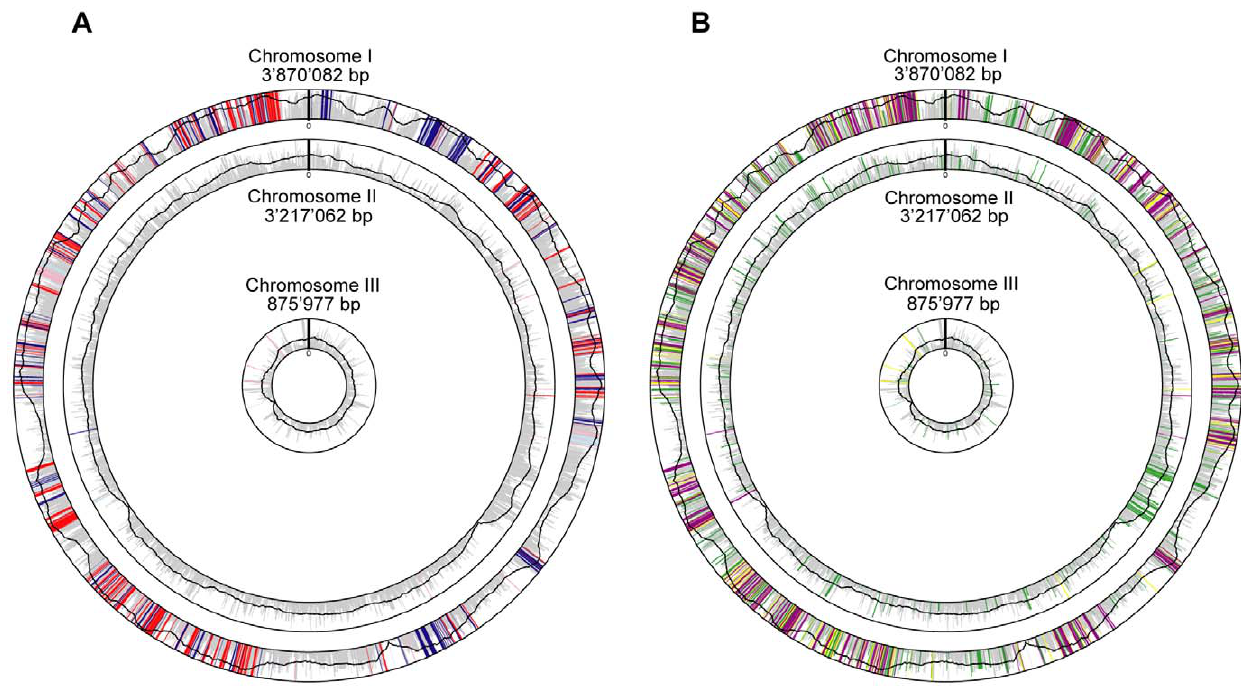
Figure 1. Chromosome 1 harbours most of the core genome. A) Schematic view of chromosomes 1–3 of Burkholderia cenocepacia J2315. The 649 genes belonging to our core genome are indicated by blue and red bars (positive or negative gene direction respectively). Core genes with homologues within the core genome are printed in light blue and rose. Other genes, which are less conserved in respect of presence within the Burkholderiales are indicated by grey bars (the height indicates the degree of conservation). The black graph also indicates the degree of conservation. 636 core genes belong to chromosome 1. Out of the remaining 13 genes, only two that are located on chromosome 2 are singletons (do not have other homologues within the genome). B) 454 core genes have homologues in the DEG database and are thus predicted to be essential (violet). Our core genome contains 195 genes without clear orthologues in the DEG database (yellow) 111 of these genes do show weak homology to DEG. The other 84 are potentially novel essential genes. 574 of B. cenocepacia J2315 homologues to the DEG database do not belong to our core genome (green). presence of glucose on agar plates (Figure 2) or in liquid medium (Figure 3). gyrB is the last gene of an operon (Figure S2).